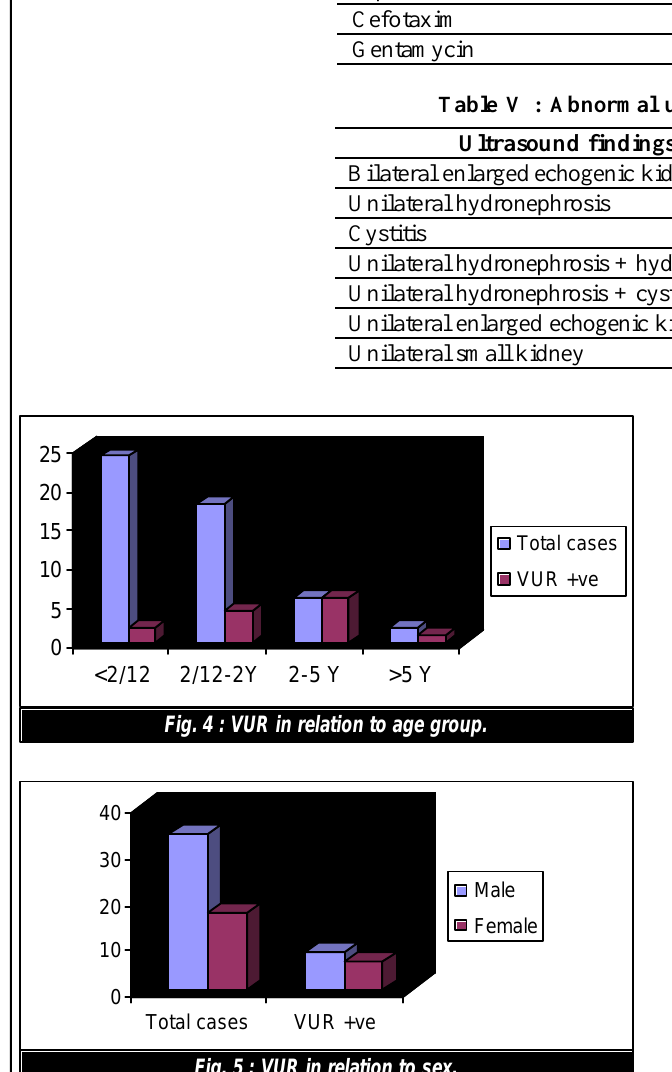
Fig. 5 : VUR in relation to